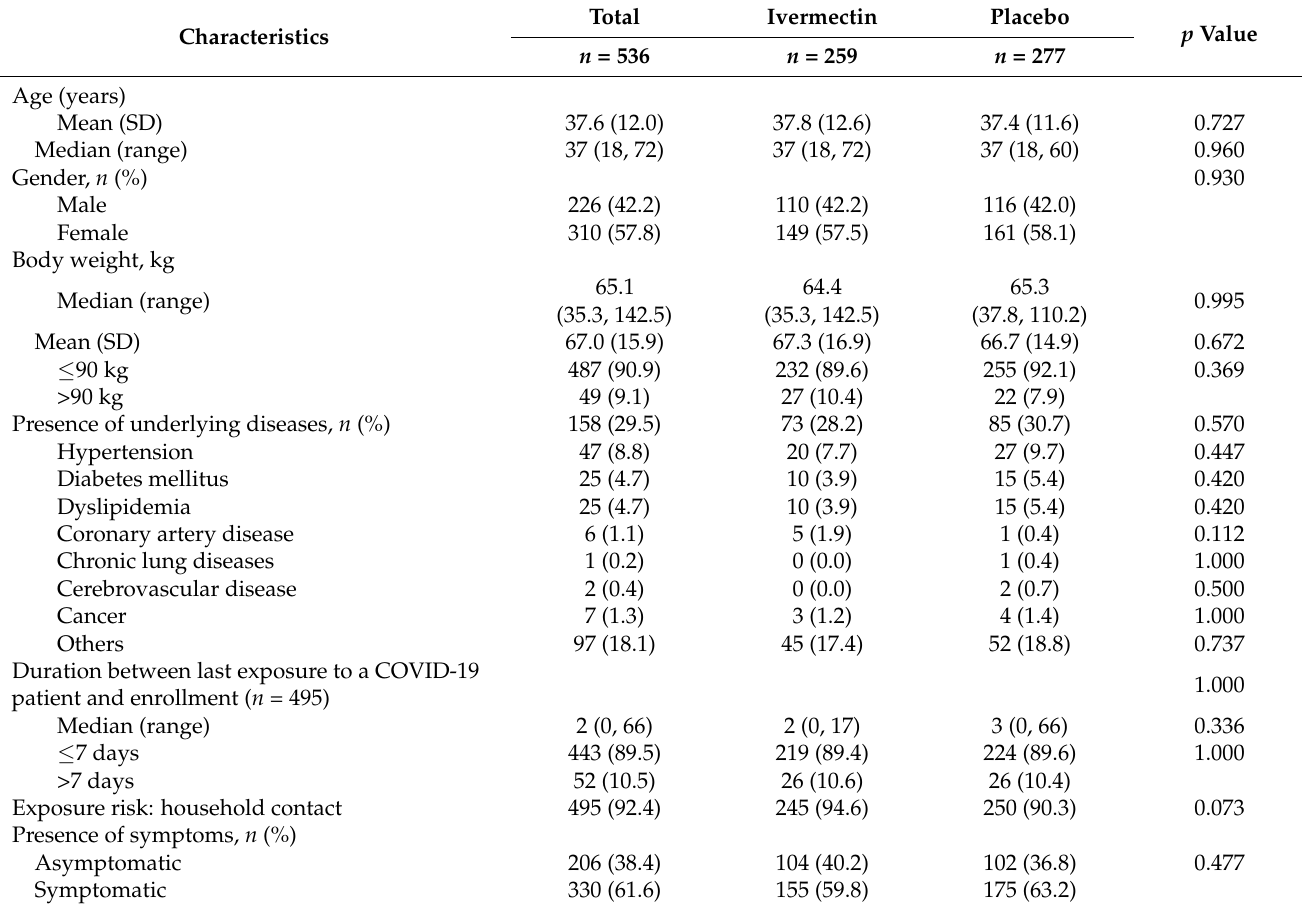
Table 1. Baseline characteristics of participants with a negative RT-PCR at enrollment in the ivermectin prevention